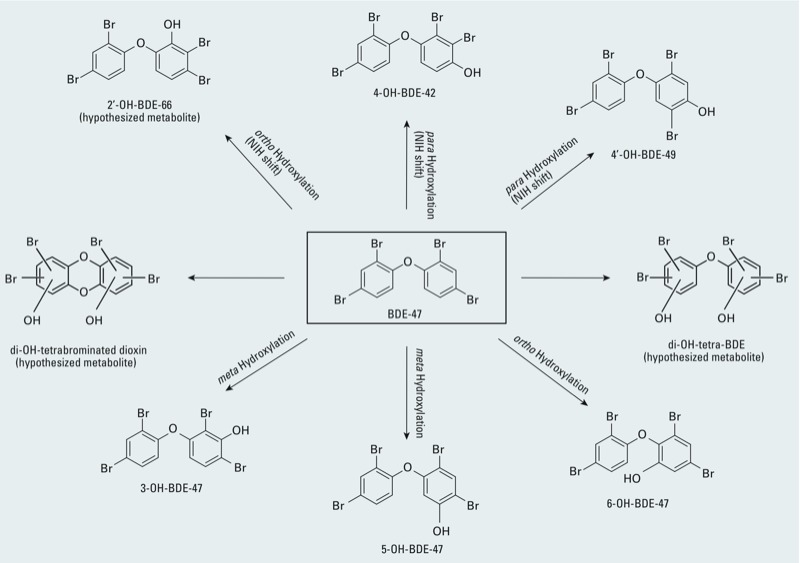
Metabolic products of BDE‑47 formed by CYP2B6. The structures of 2´‑MeO-BDE‑66, di‑OH-BDE, and di‑OH-tetrabrominated dioxin are hypothesized based on mass spectra data. NIH shift, intramolecular migration of a hydrogen atom primarily during hydroxylation.